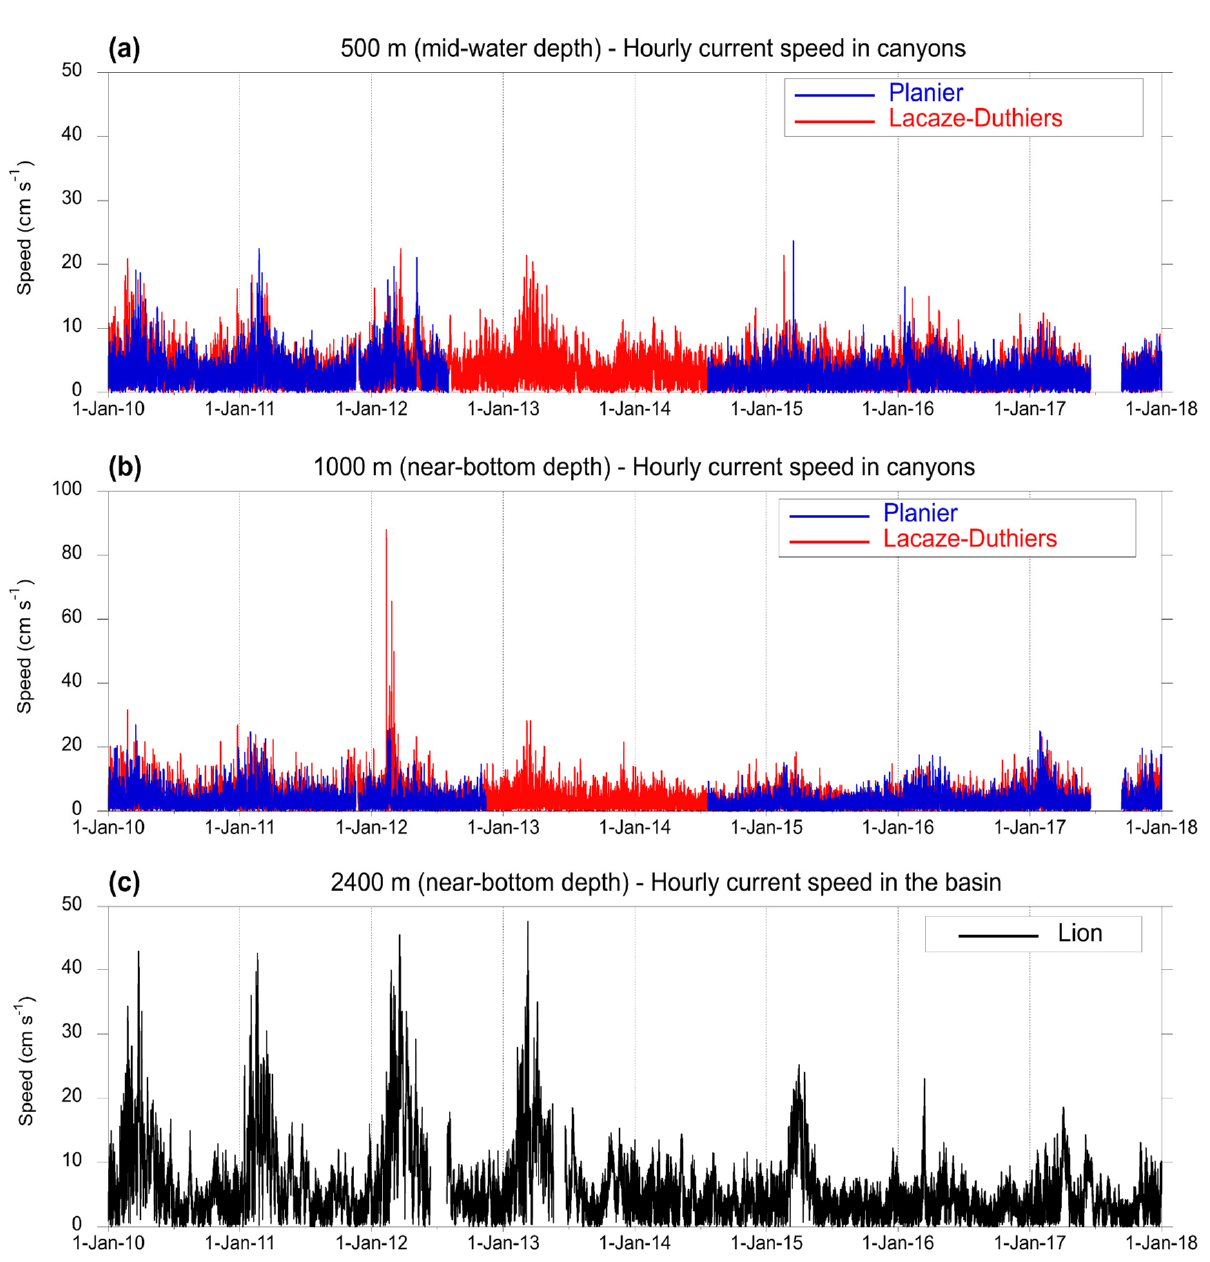
Figure 3. The 2010–2017 hourly time series of current speed ( a ) at 500 m deep (mid-water) in the Planier and Lacaze-Duthiers Canyons, ( b ) at 1000 m deep (near-bottom) in the Planier and Lacaze-Duthiers Canyons, ( c ) at 2400 m deep (near bottom) in the basin at the Lions site. See Figure 1 for the location of the sites.